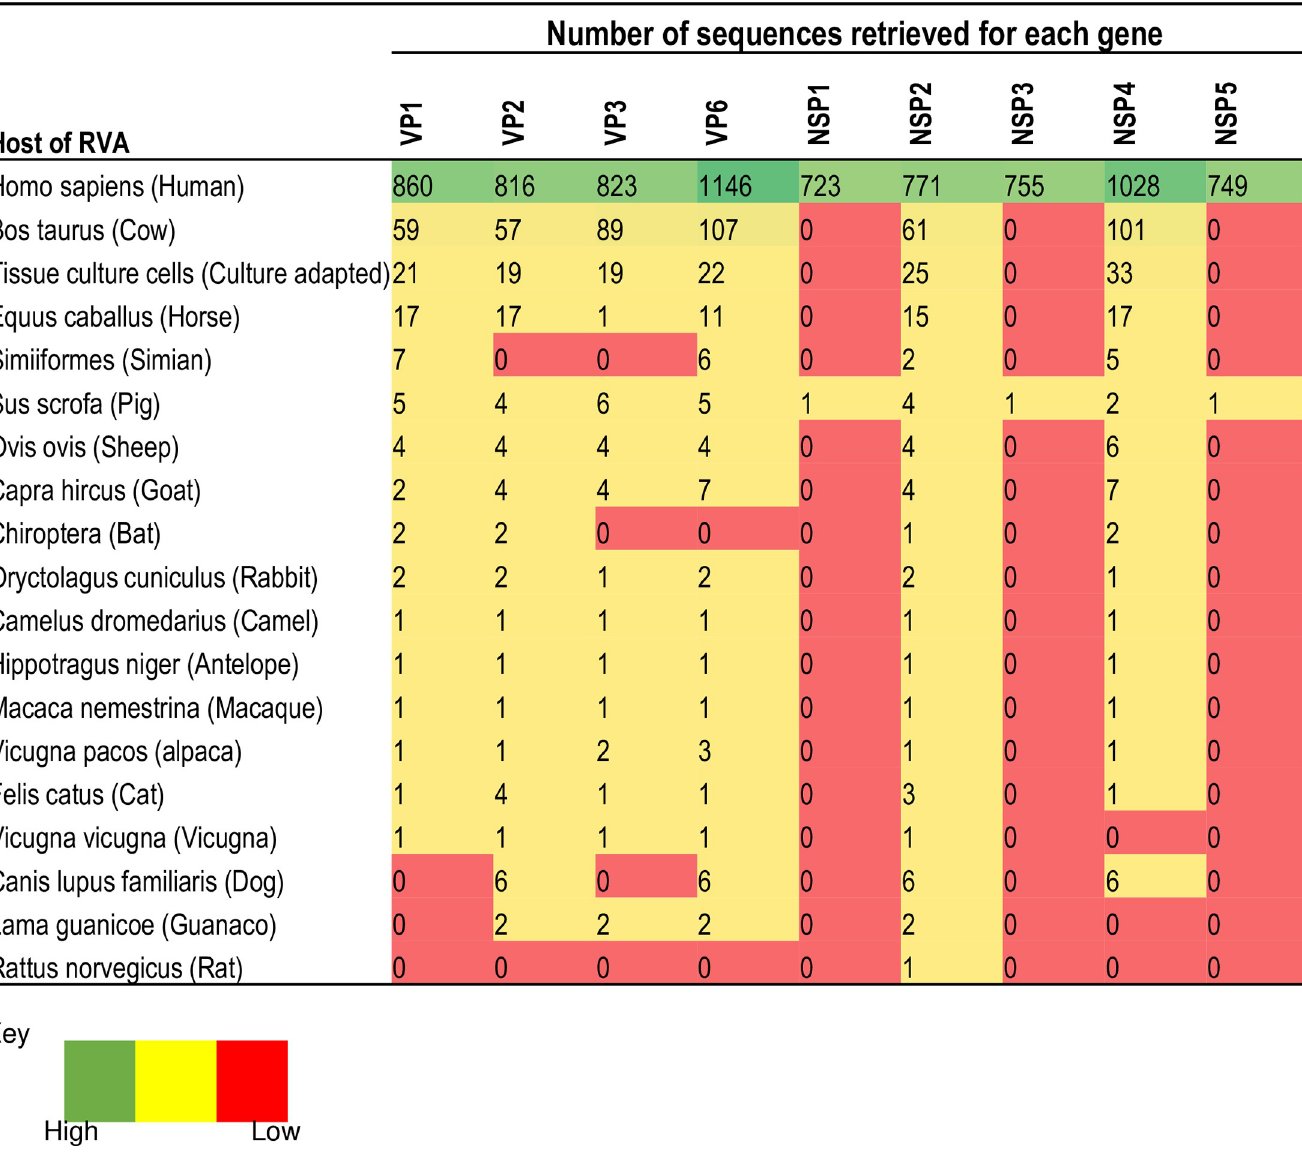
Fig 2. Host distribution/isolation source of genotype 2 genes retrieved from the GenBank using the virus variation rotavirus resource.